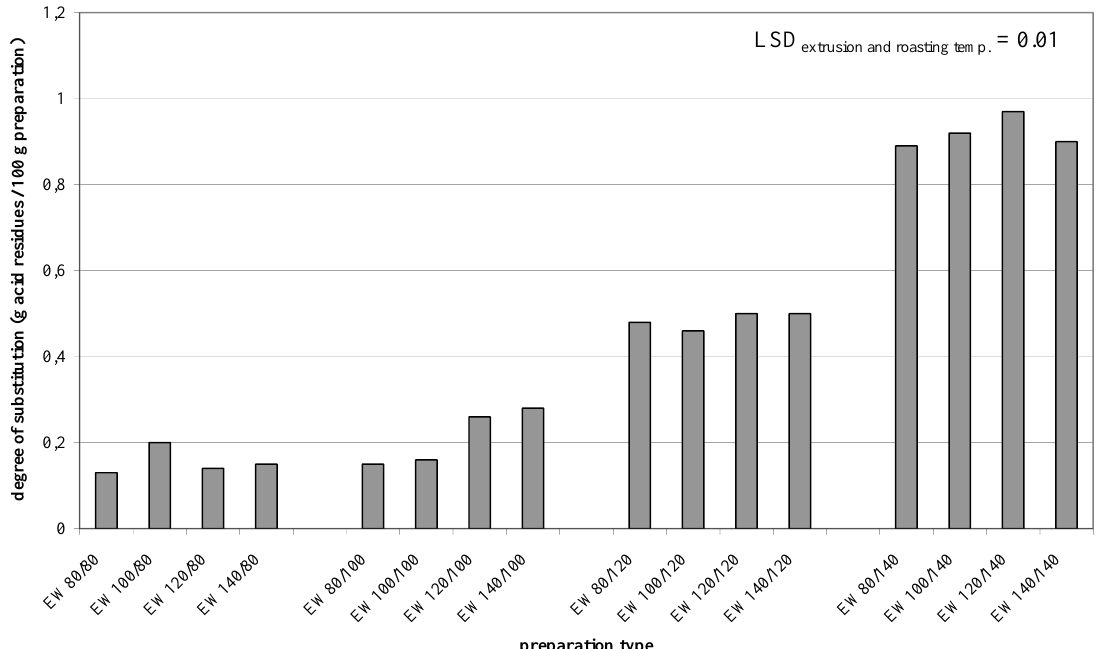
Figure 1. Degree of substitution of esters produced by starch extrusion with apple distillery wastewater and roasting (EW).